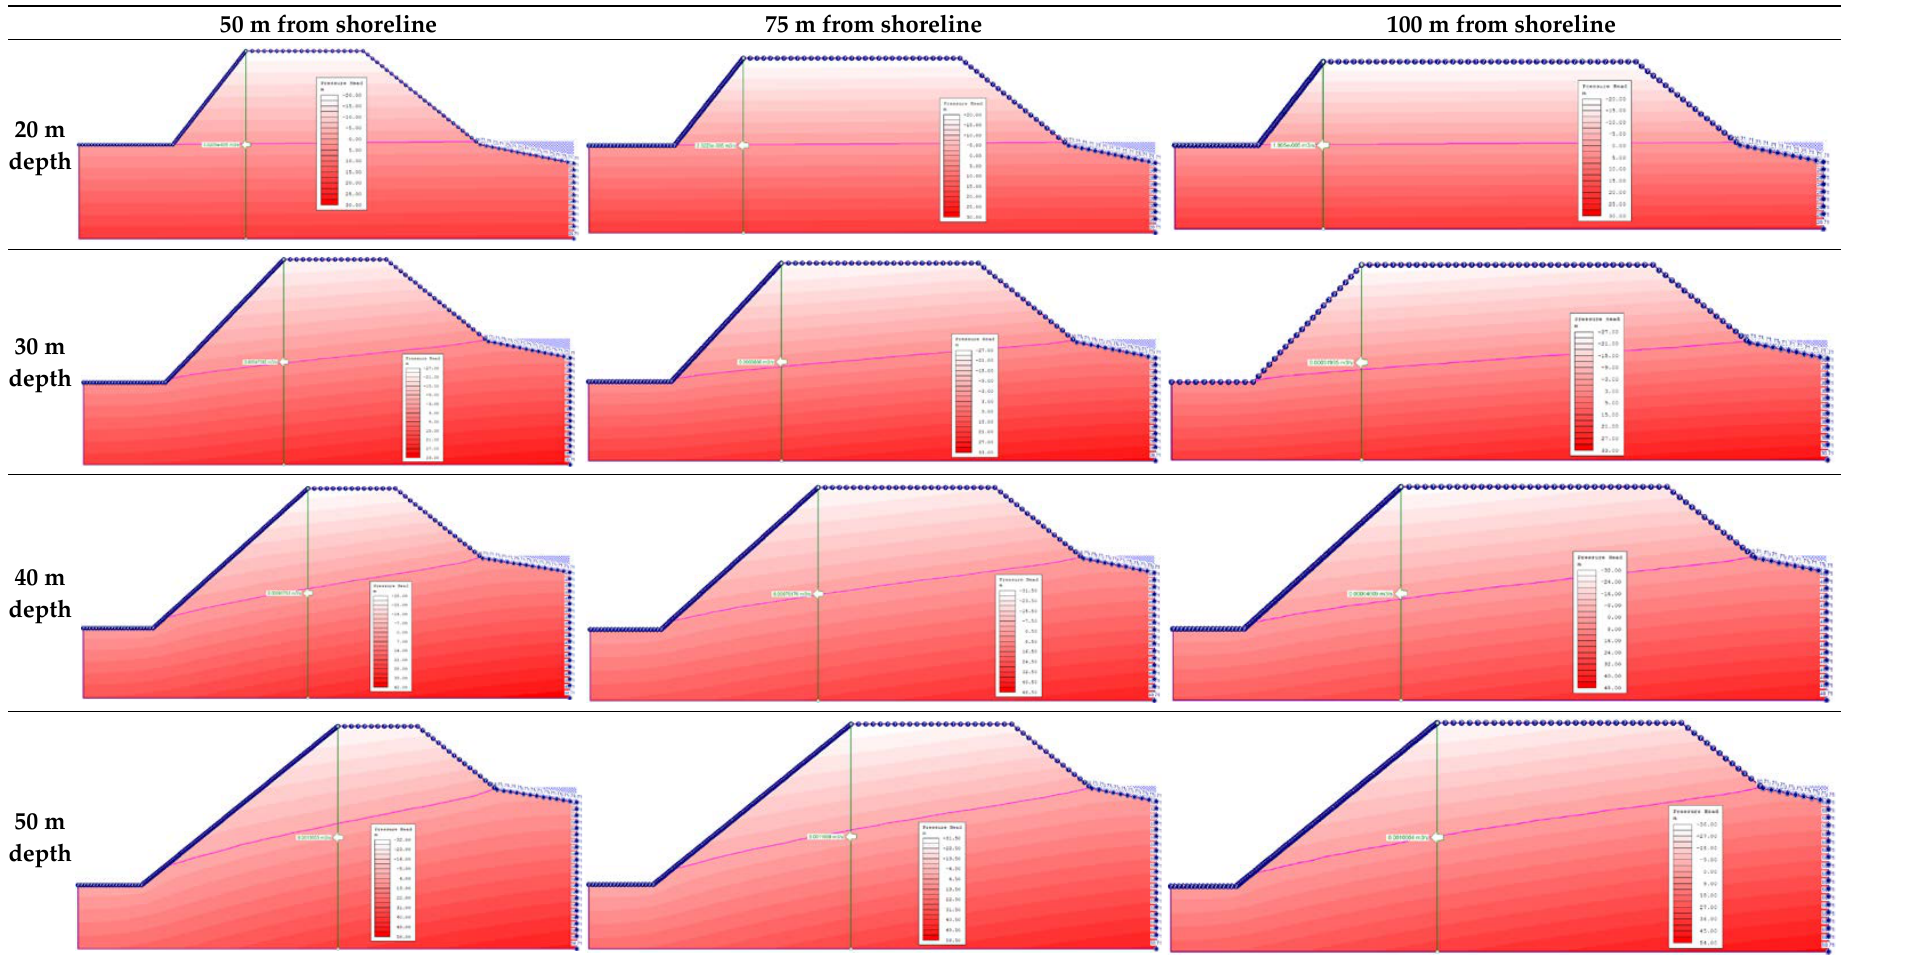
Figure 11. Variation of pressure heads with excavation depth and distance from shoreline.